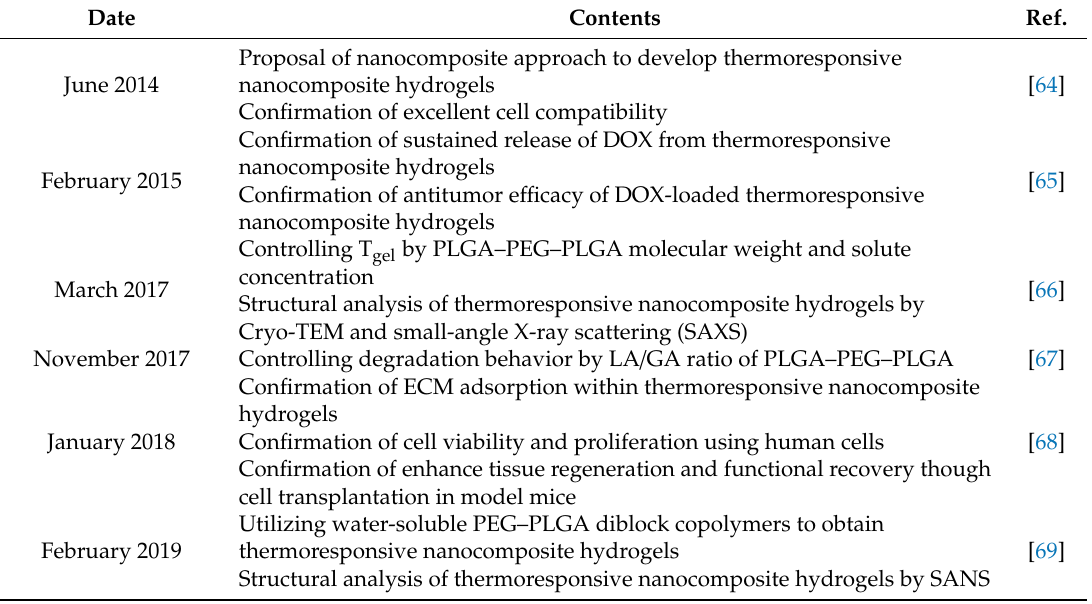
Table 4. Development history of thermoresponsive nanocomposite